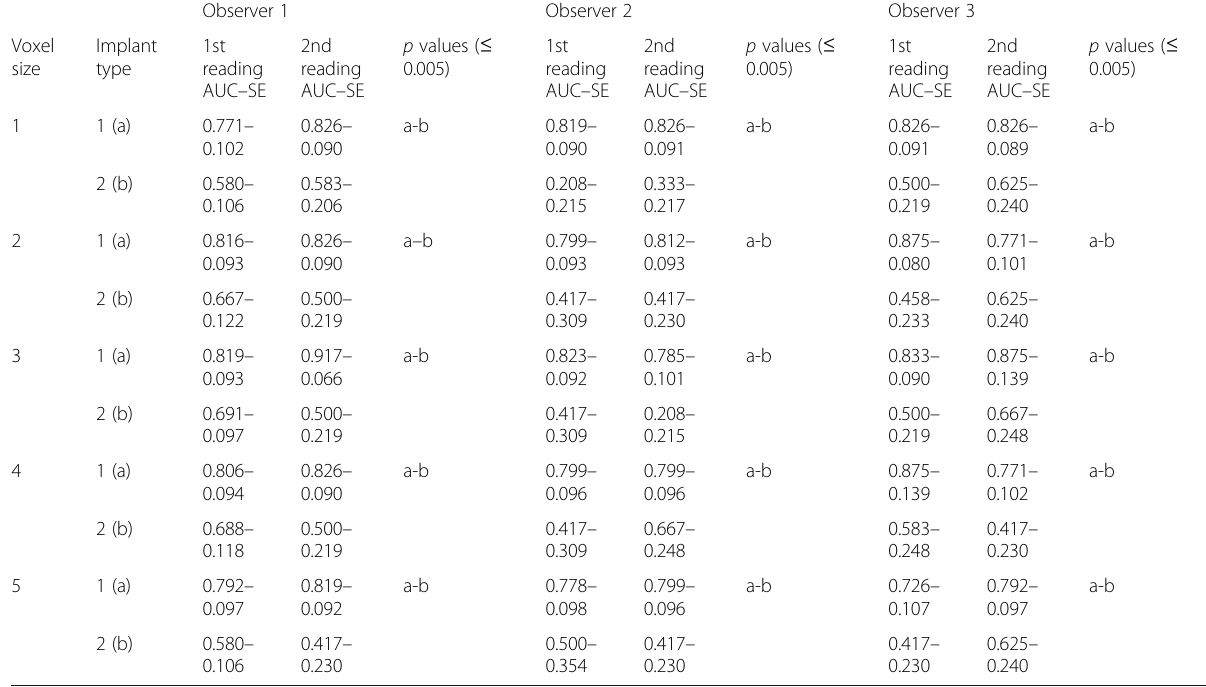
Table 3 AUC values according to scan modes and implant types for 1st and 2nd readings of the observers Observer 1 Observer 2 Observer